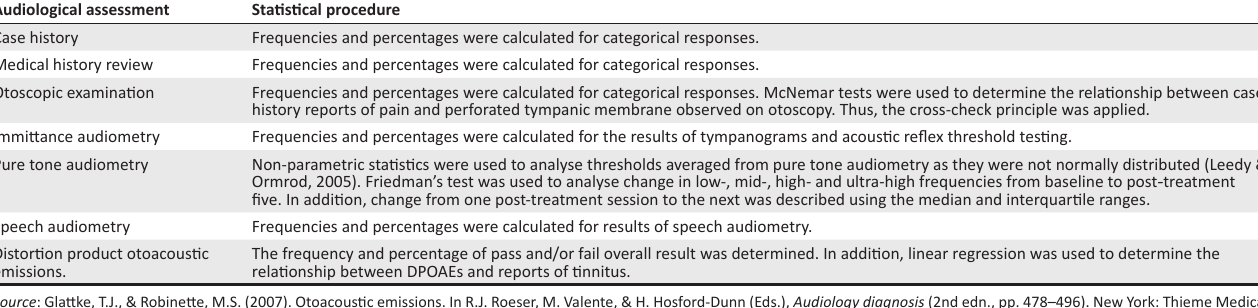
FIGURE 1: Treatment of other co-morbidities. TABLE 1: Audiological assessment and statistical procedures for